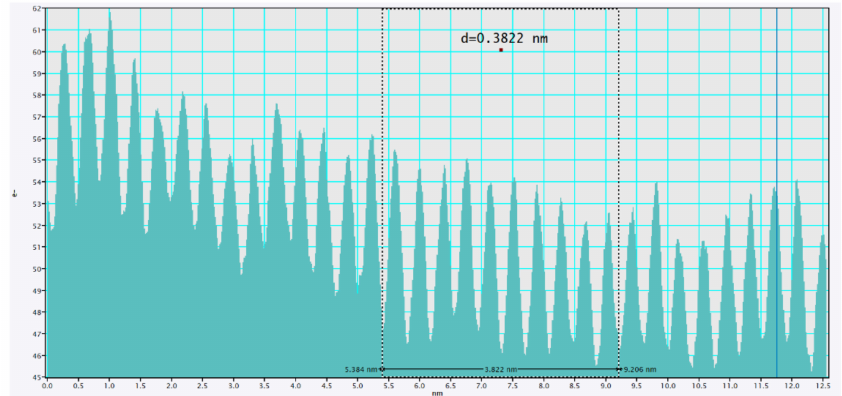
Figure A2. d-spacing from the HRTEM micrograph of Cu 3.21 Bi 4.79 S 9 .